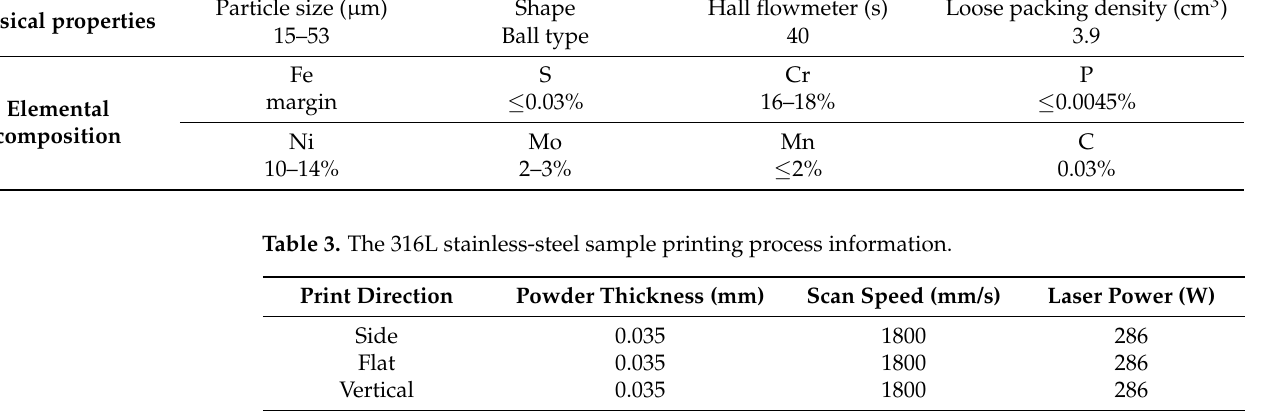
Figure 4. Schematic diagram of sample printing: ( a ) printing direction; ( b ) finished product.